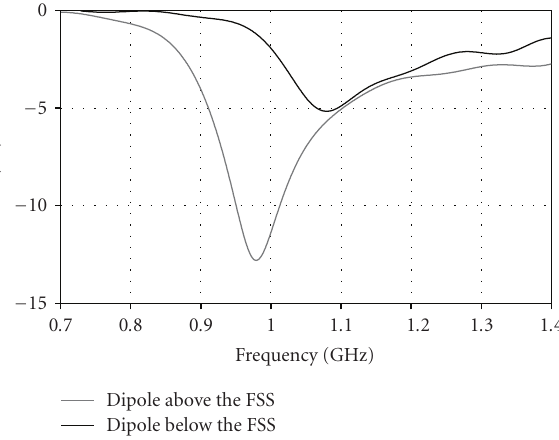
Figure 16: Radiation patterns in the E-plane.